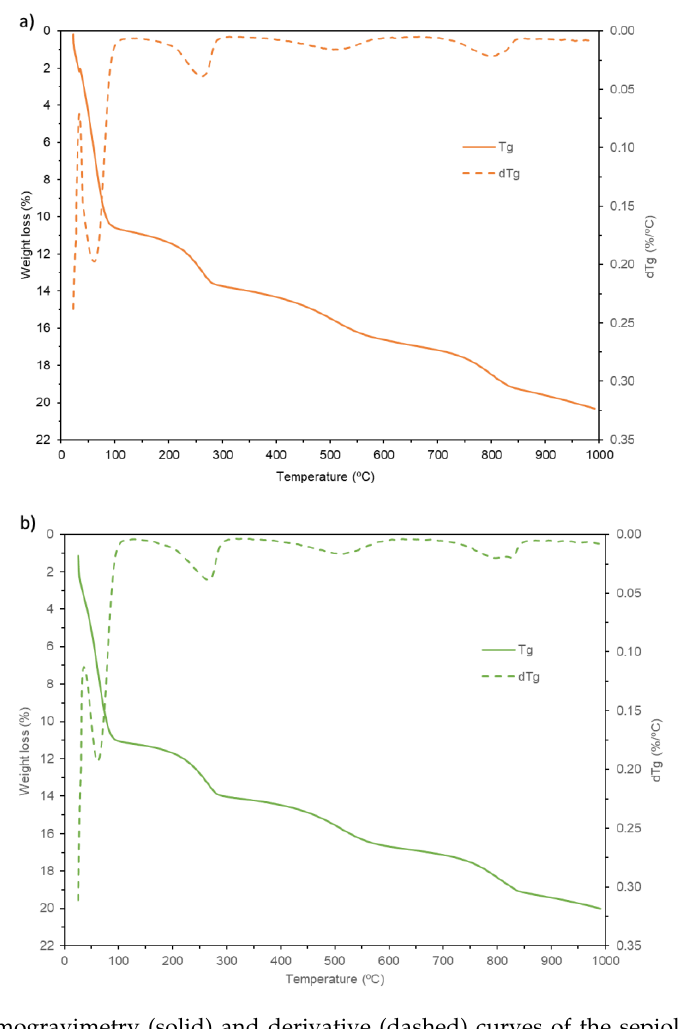
Figure 2. Thermogravimetry (solid) and derivative (dashed) curves of the sepiolite samples: ( a ) sepiolite 1; ( b ) sepiolite 2.